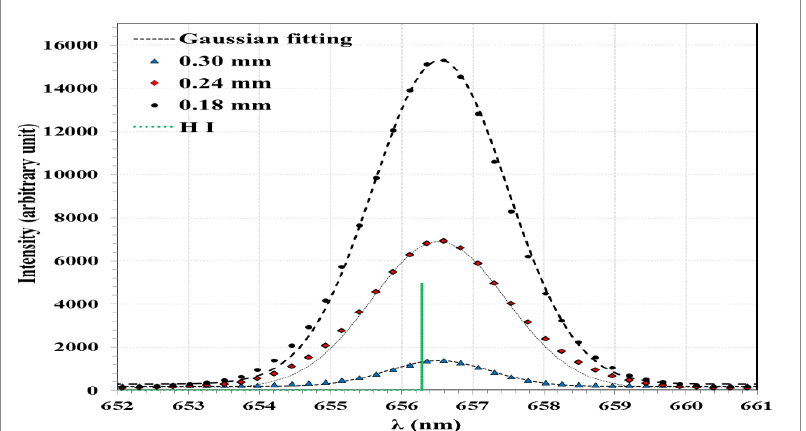
Fig. 4: Cu I 656.279 nm peaks broadening and there Gaussian fitting using different wire diameters.